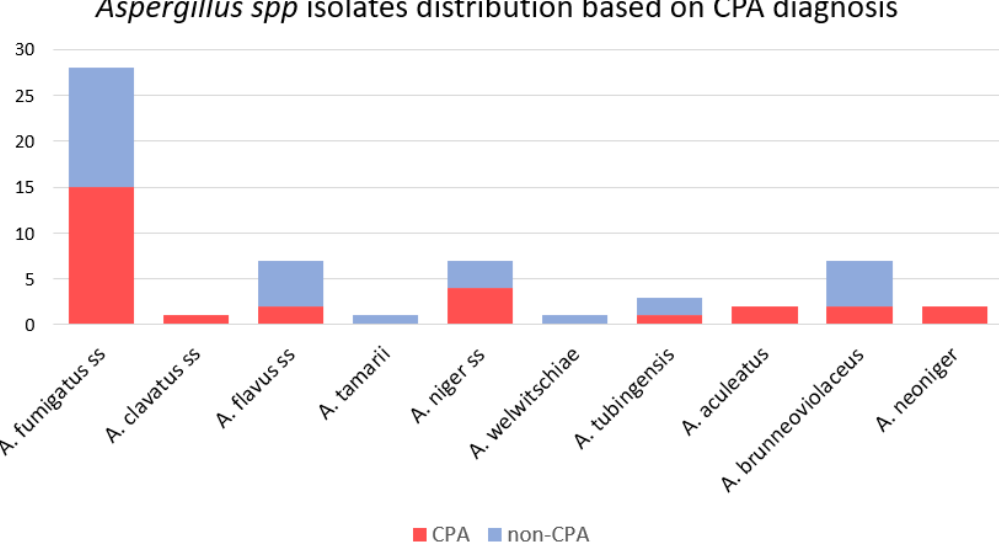
Figure 3. Antifungal resistances of Aspergillus in each section ( A ) Flavi section, ( B ) Nigri section, ( C ) Fumigati section and its correlation with CPA diagnosis.